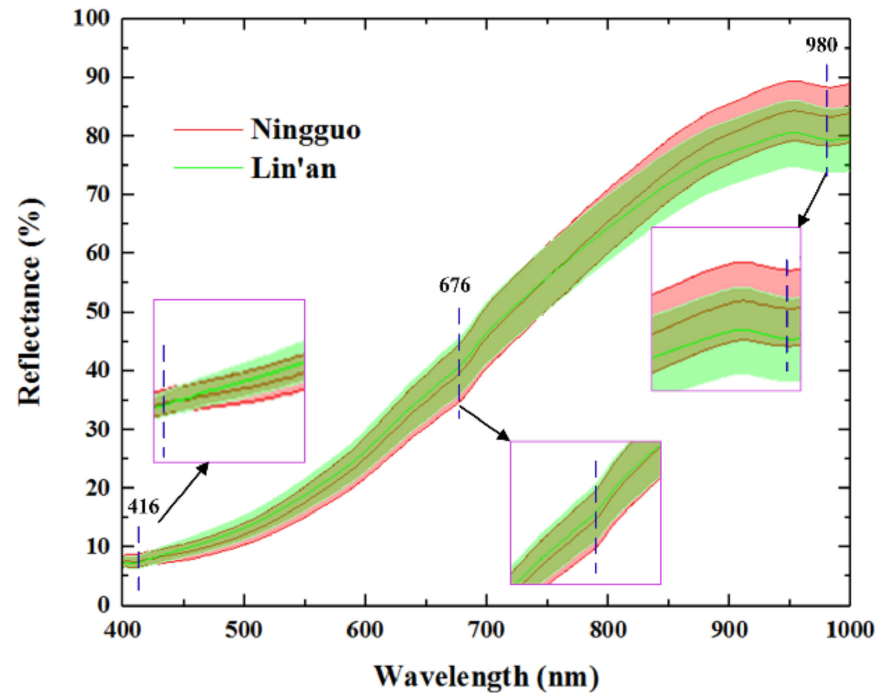
Figure 1. The average reflectance spectral curves of Chinese walnut samples of Ningguo and Lin’an varieties with standard deviation